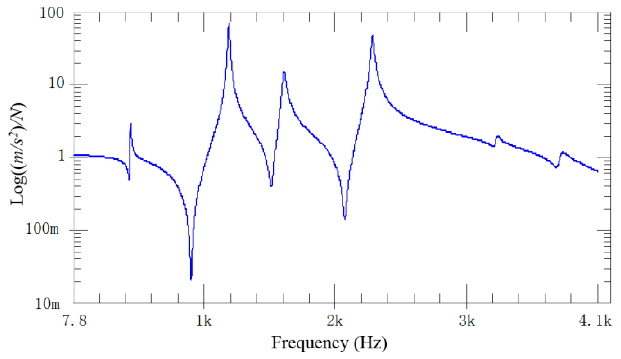
Figure 5. Frequency response function.